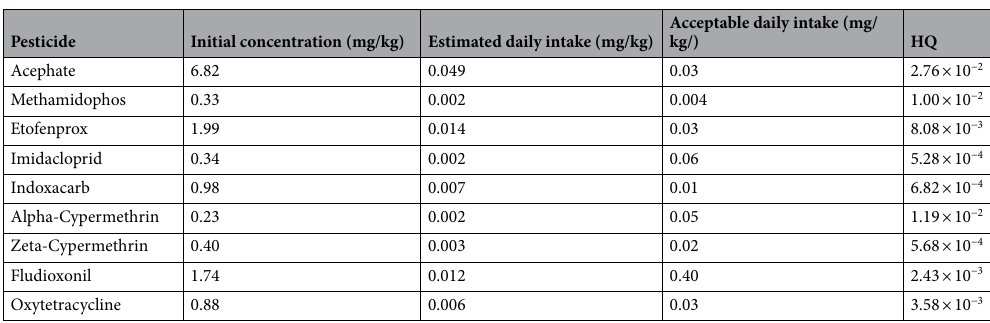
Table 4. Estimated daily intake of pesticides via the dietary intake of Brussels sprout.